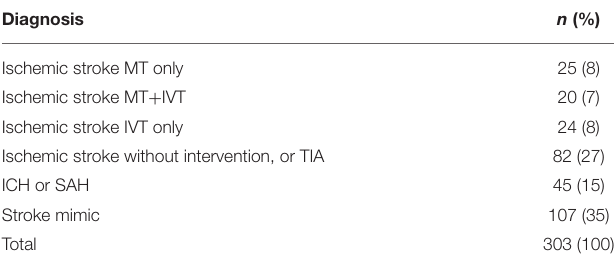
TABLE 3 | Final diagnoses of rerouted